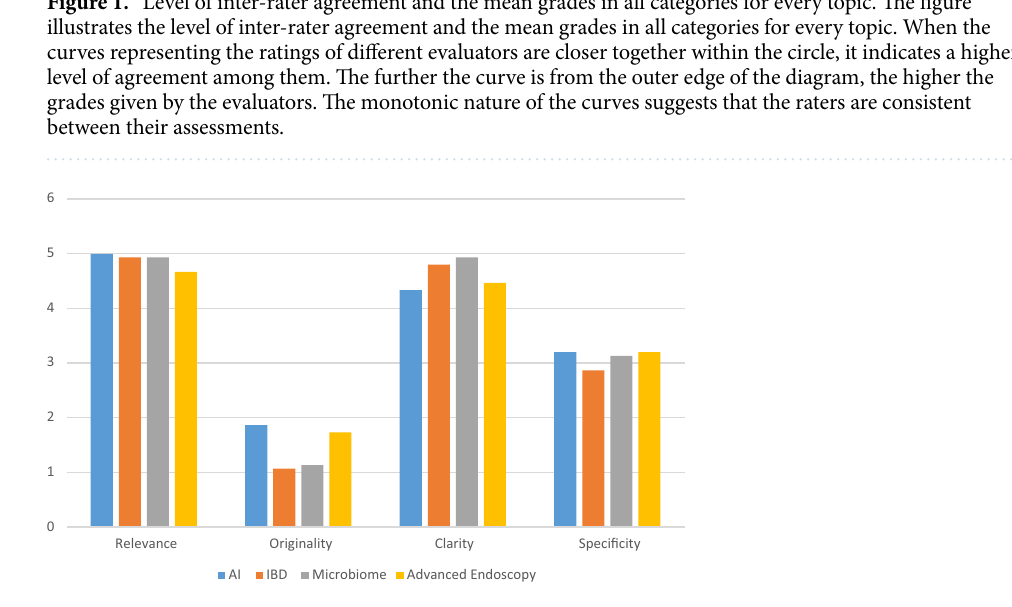
Figure 2. Mean scores for each research topic and category, as rated by all